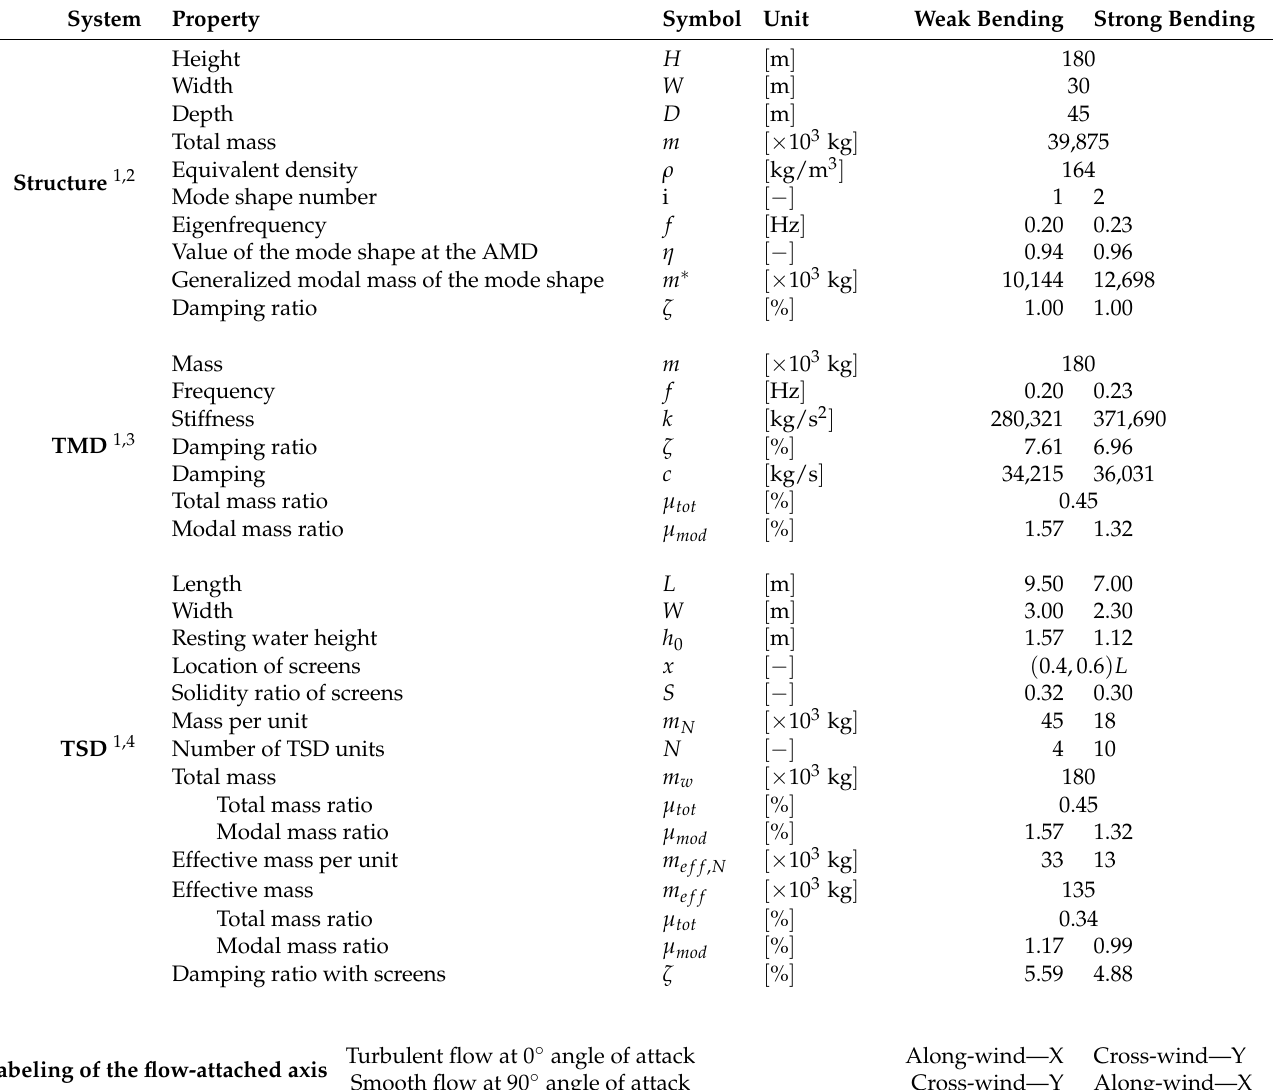
Table 2. Setup of the interacting systems—tructure and AMDs—using the definitions based on the structure-attached coordinate